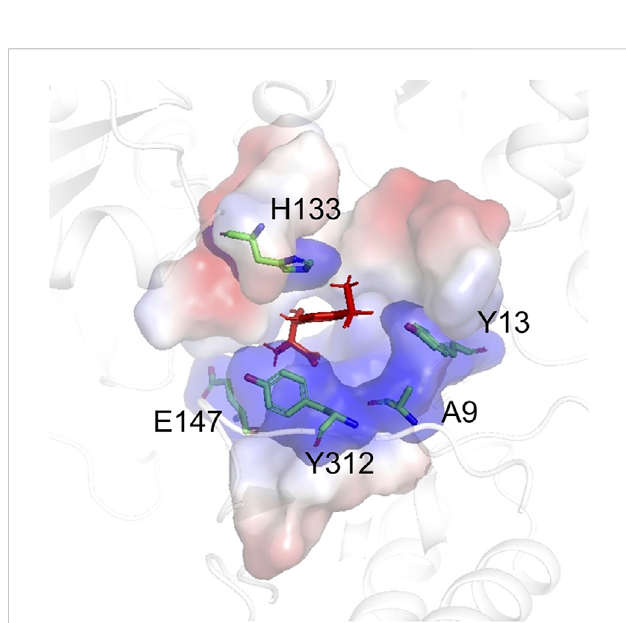
FIGURE 5 The model structure of WT L -PpTA. The enzyme backbone is represented as a cartoon in white. The substrate binding pocket is represented as a surface. The MSPS is indicated by red sticks.